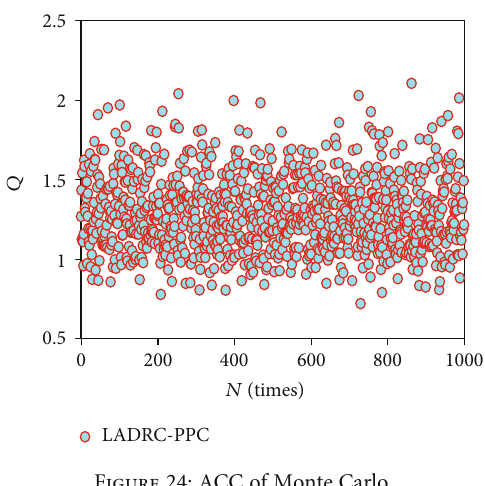
Figure 21: AV of Monte Carlo.